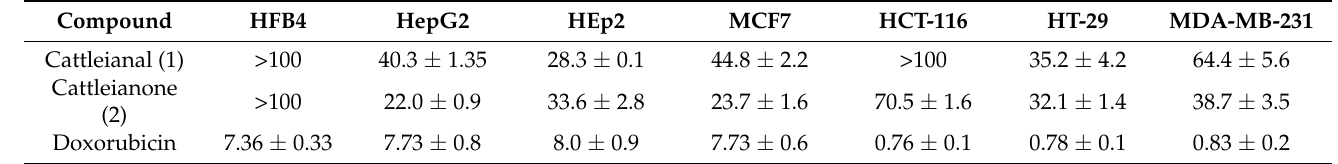
Table 1. Results of the cytotoxic effect of cattleianal and cattleianone on different human cell lines. Compound Cattleianal (1)